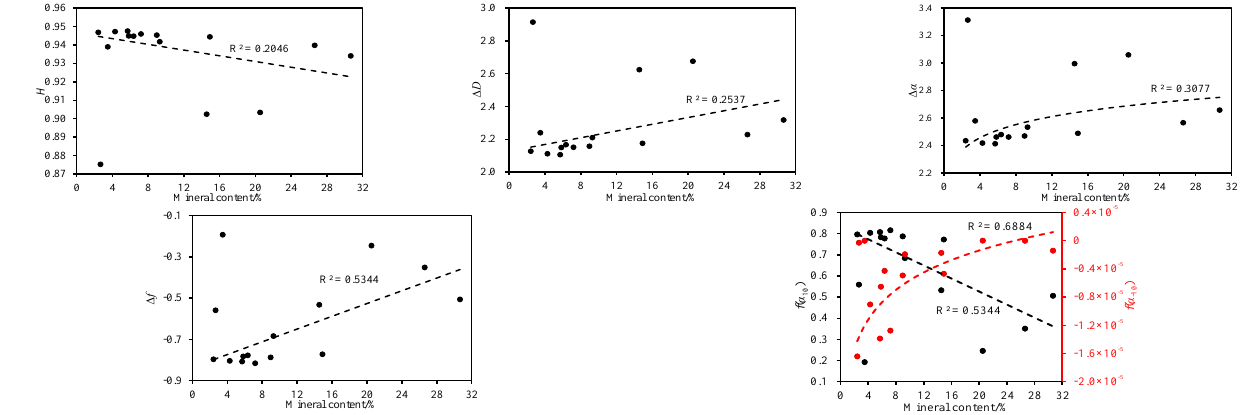
Figure 10. The relationship between multifractal parameters and M ad. In coal composition, mineral content has a weak negative correlation with H and a weak positive correlation with Δ D , Δα and Δ f (Figure 11), which means that the increase in mineral content enhances the complexity of pore structure and deteriorates the pore connectivity of the reservoir. Heterogeneous coal macromolecules are interlinked to form extremely rough and uneven pore surfaces [40], and most minerals accumulate and fill in the pore-fracture system of the coal matrix. Due to the influence of mineral blockage, the pore structure in coal is more complicated. Clarkson and Wilson believed that mineral filling would produce obvious protrusions and increase the irregular and disordered surface shape of coal samples [41], and the roughness of the pore surface and the complexity of the pore structure are increased. Removing the mineral particles filled in the pore can simplify the pore structure and increase the homogeneity of the pore structure.